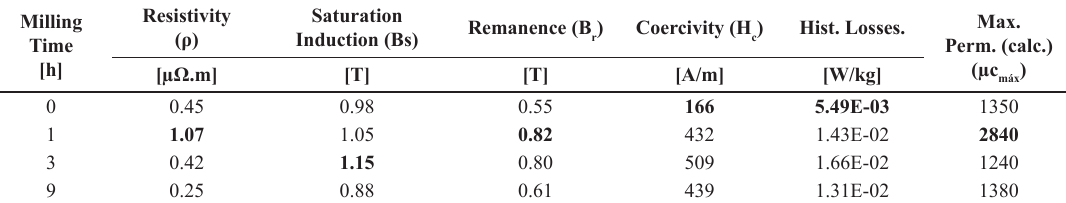
Table 1. Magnetic and electrical properties of the alloy Fe-3Si-0.75P after milling. Milling